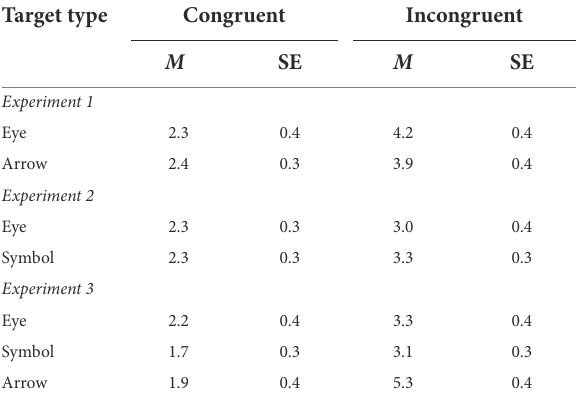
TABLE 1 Means error rates (percentage incorrect) and within-subjects standard errors in Experiments 1–3. Target